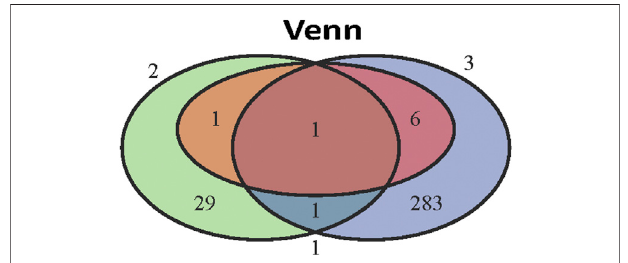
FIGURE 6 | The key role of CCL20 in LUAD. Venn diagram of eight independent risk scoring genes, 32 genes related to poor differentiation and 291 LDRGs.